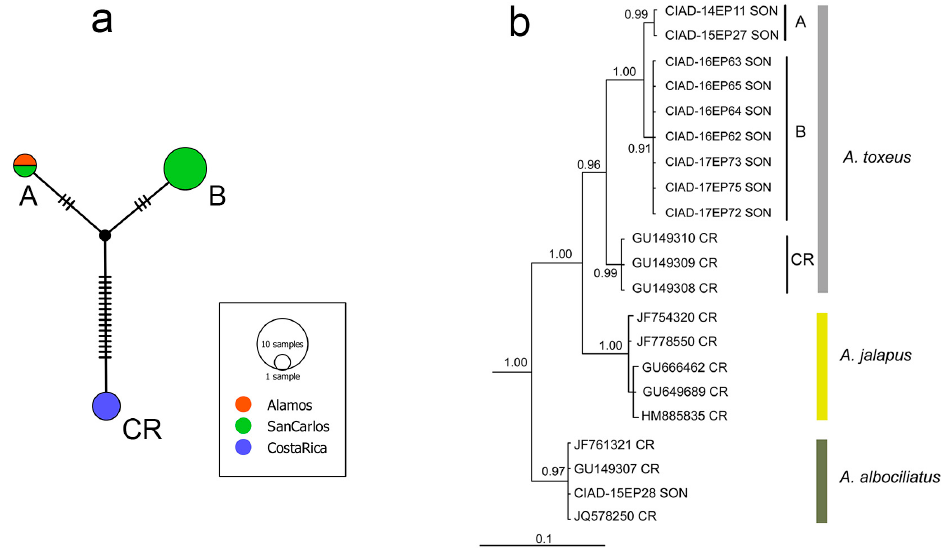
Figure 4. ( a ) Median ‐ joining haplotype network of the 658 bp COI barcode segment in Achalarus toxeus showing relationships among haplotypes A ( n = 2) and B ( n = 7) from Alamos and San Carlos, Sonora, and haplotype CR (n = 3) from the Area de Conservación Guanacaste (ACG), Costa Rica. Sizes of the circles are proportional to sample size. Each hatch mark on lines connecting haplotypes represents a single nucleotide substitution. The small black circle represents an inferred intermediate haplotype. ( b ) Bayesian 50% majority rule consensus tree of barcode sequences of the three haplotypes of A. toxeus (A, B and CR), and the partitioning of clades of two other cryptic species in this complex, A. jalapus and A. albociliatus (see text). Clade support values (posterior probabilities) for the major clades are shown on branches. The scale represents expected substitutions per site. Abbreviations: SON, Sonora (Mexico); CR, Costa